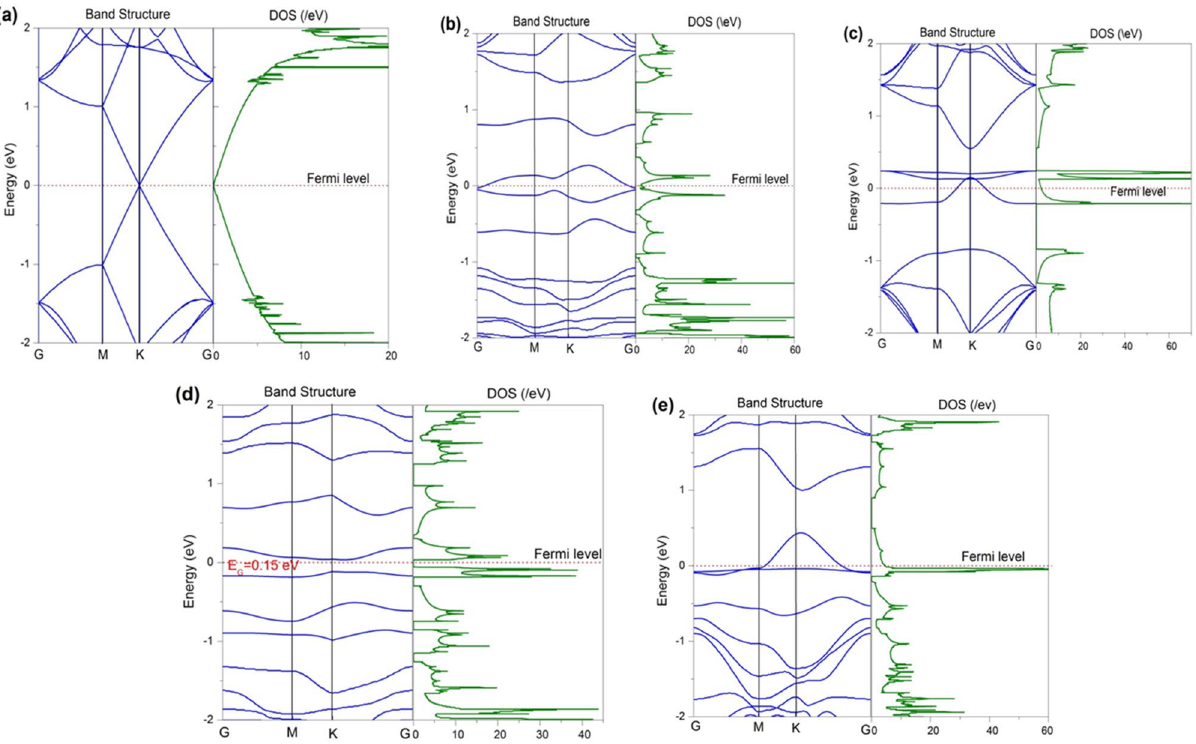
Figure 4. Band structure and DOS profiles for ( a ) pristine GNs, ( b ) 2% defected GO, ( c ) 2% defected GNs, ( d ) 6% defected GO, and ( e ) 6% defected GNs.